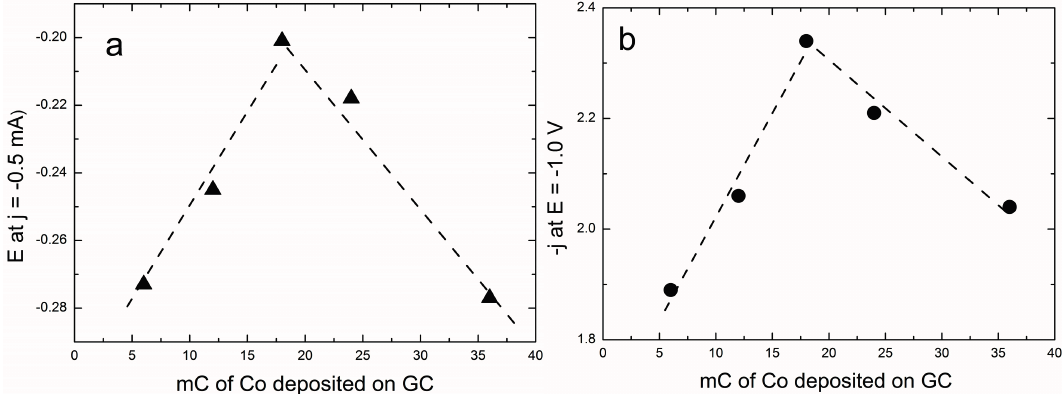
Figure 4. ( a ) Volcano curve as obtained by plotting the potential values at j = − 0.5 mA·cm − 2 , and ( b ) the current density values at E = − 1.0 V versus the charge associated with the Co deposits on